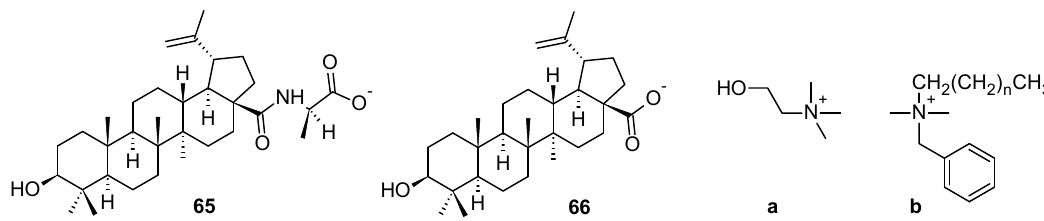
Figure 3. Ionic derivatives of betulinic acid ( 1 ) with antiviral activity against herpes simplex virus HSV-2.